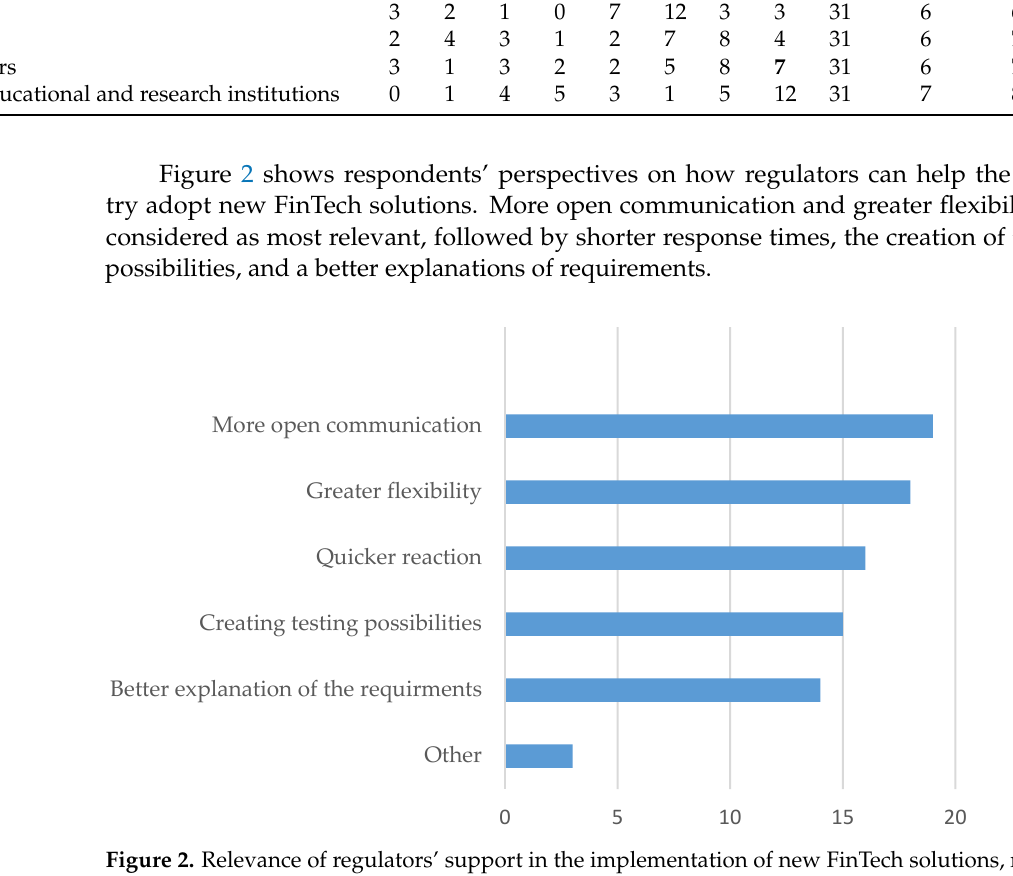
Figure 3. Factors restricting the expansion of FinTech companies into foreign markets (except regulation); 1 = not restrictive, 7 = extremely restrictive, medians. The respondents’ assessment of potential areas for development is presented in Figure 4. The respondents see the greatest potential for growth in open banking (19 out of 31 participants) as an area for development, followed by lending activities (14), digital currencies (13), data analysis (13) and instant payments (12). Insurance services (9), wealth